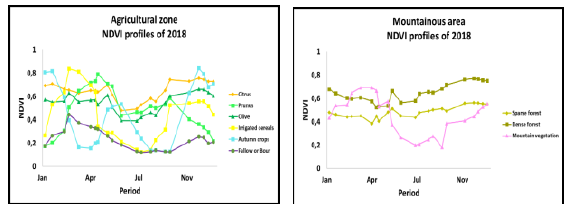
Figure 3. 2018 NDVI profiles extracted from the agricultural zone on the left, and mountainous area on the